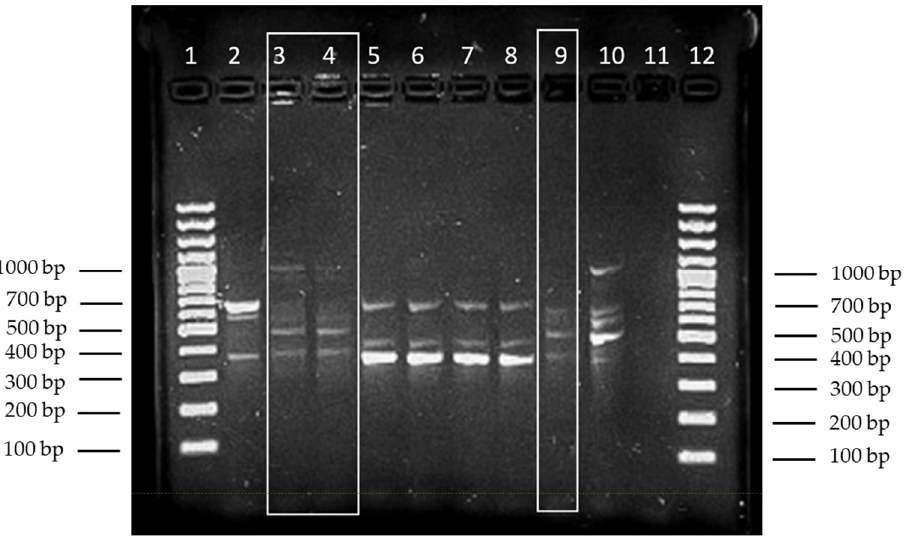
Figure 3. Results for the subtyping of different Aeromonas spp. strains using RAPD PCR with Eric2 primers. Aeromonas veronii strains from blood culture (column 9) and from leeches of the same container as those used on the patient (columns 3 and 4) showed an identical pattern. Aeromonas hydrophila strains from 4 leeches from a different container (columns 5–8) showed a pattern identical to each other but a different to that of the patient strain. Aeromonas hydrophila strains from independent patients showed independent patterns (columns 2 and 10). Columns 1 and 12 are lambda